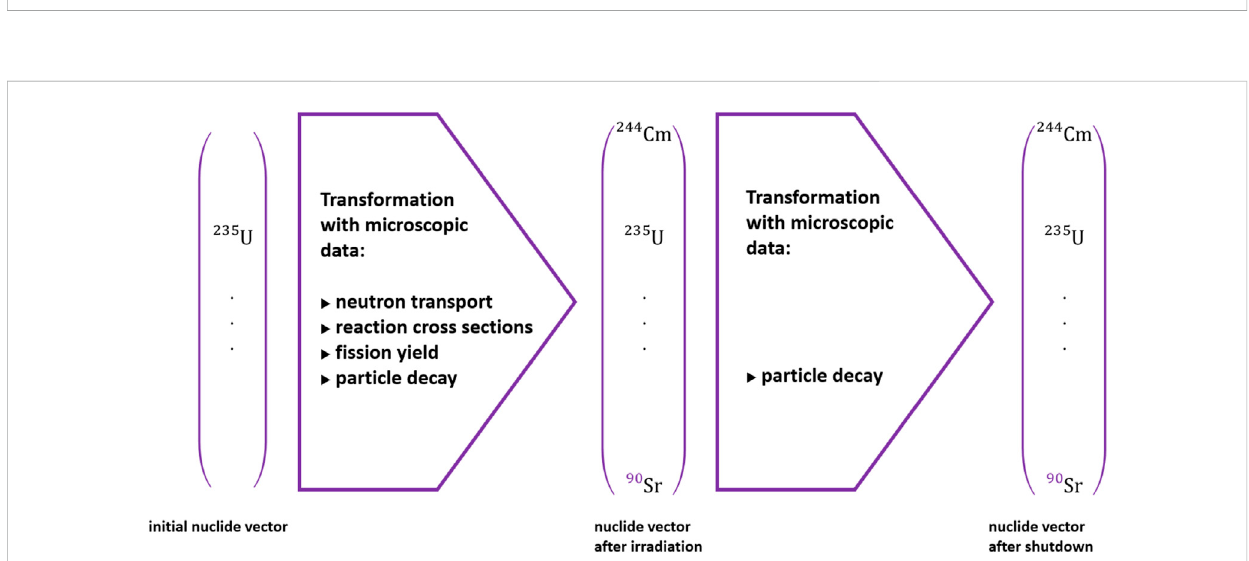
Frontiers in Energy